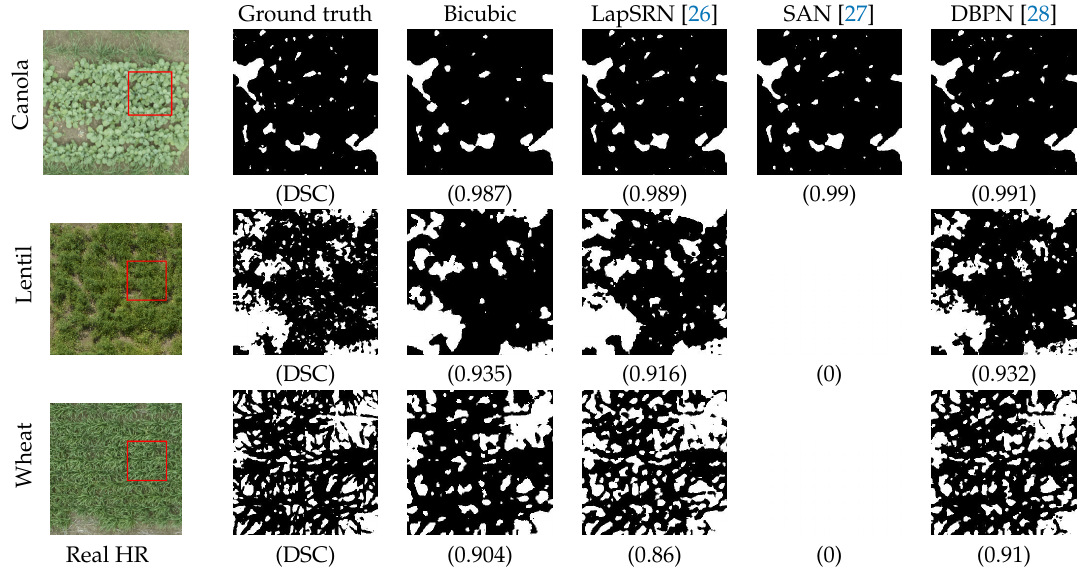
Figure 8. Example test images from the synthetic-synthetic experiment for canola, lentil and wheat datasets (top/middle/bottom rows). Ground truth HR images (left) are shown with the cropped region denoted by a red box. Black pixels indicate vegetation segmentation (foreground) and DSC values are listed below each image.